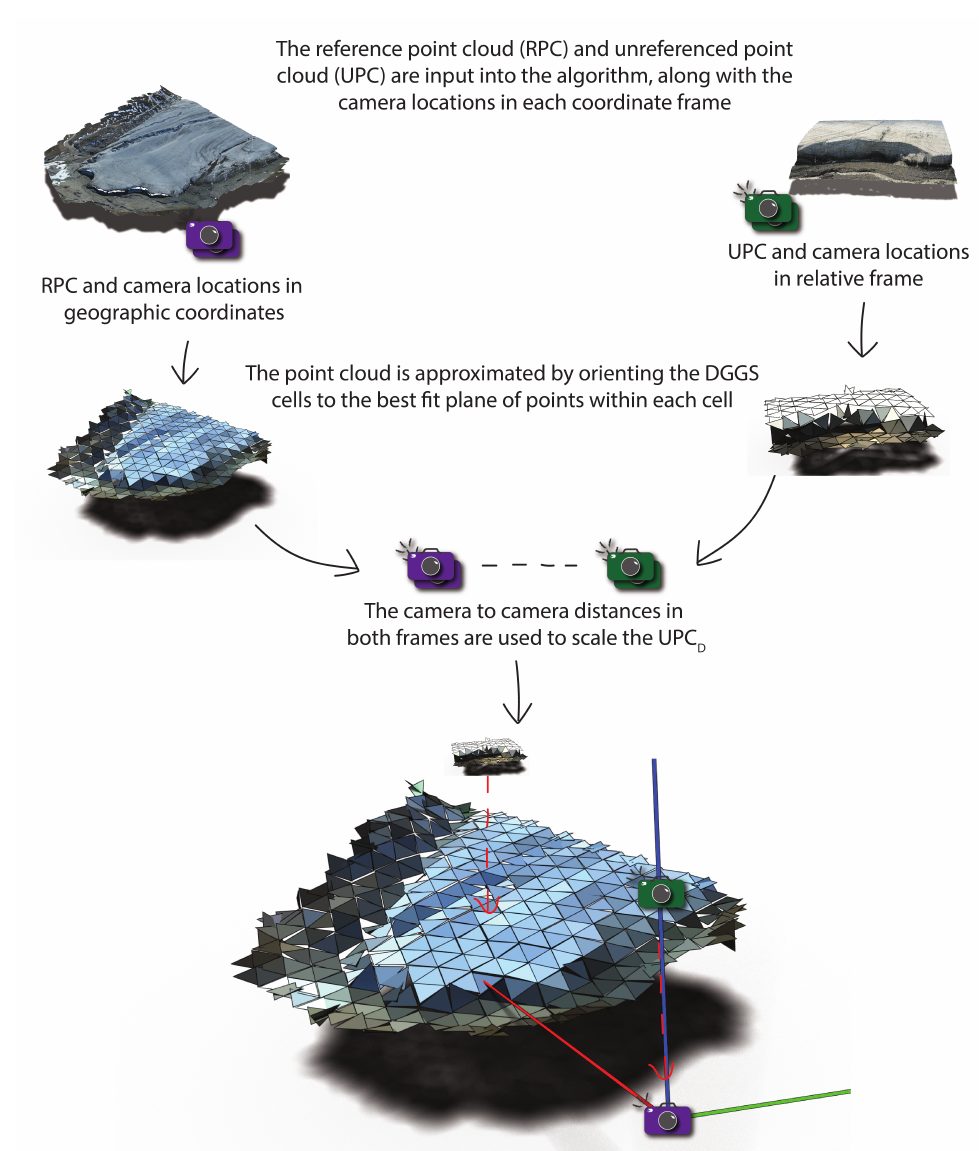
Figure 2. Process visualization of data loading into the DGGS for processing and the initial solution calculation before optimization. The reference frame of the UPC is indicated with the red-green-blue axes. The look-at-ray points along the red